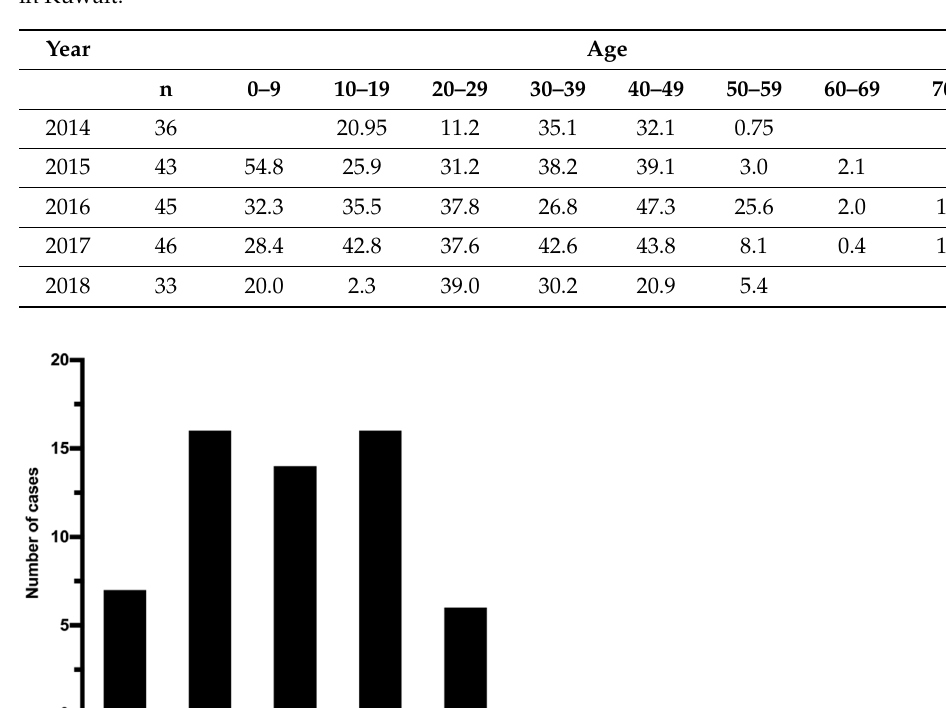
Table 1. Average COHb% in blood specimens of all CO poisoning cases (n = 203) by age groups in Kuwait.